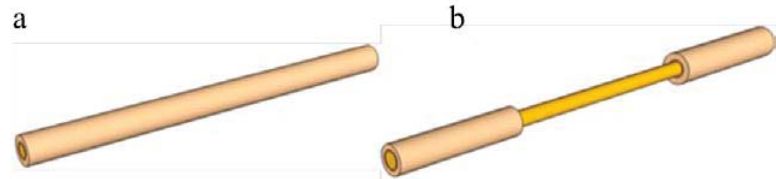
Figure 1. Schematic of the fiber sensor: ( a ) crude fiber; and ( b ) fiber sensors (window